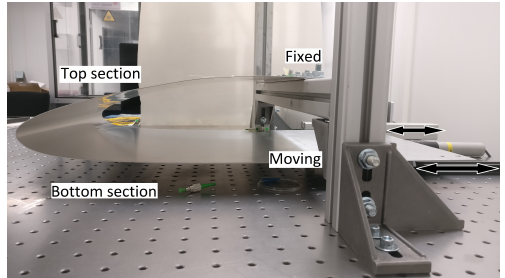
Figure 5. Side view of the wing attached to the support beams. The top section is fixed whilst the bottom section is allowed to slide.